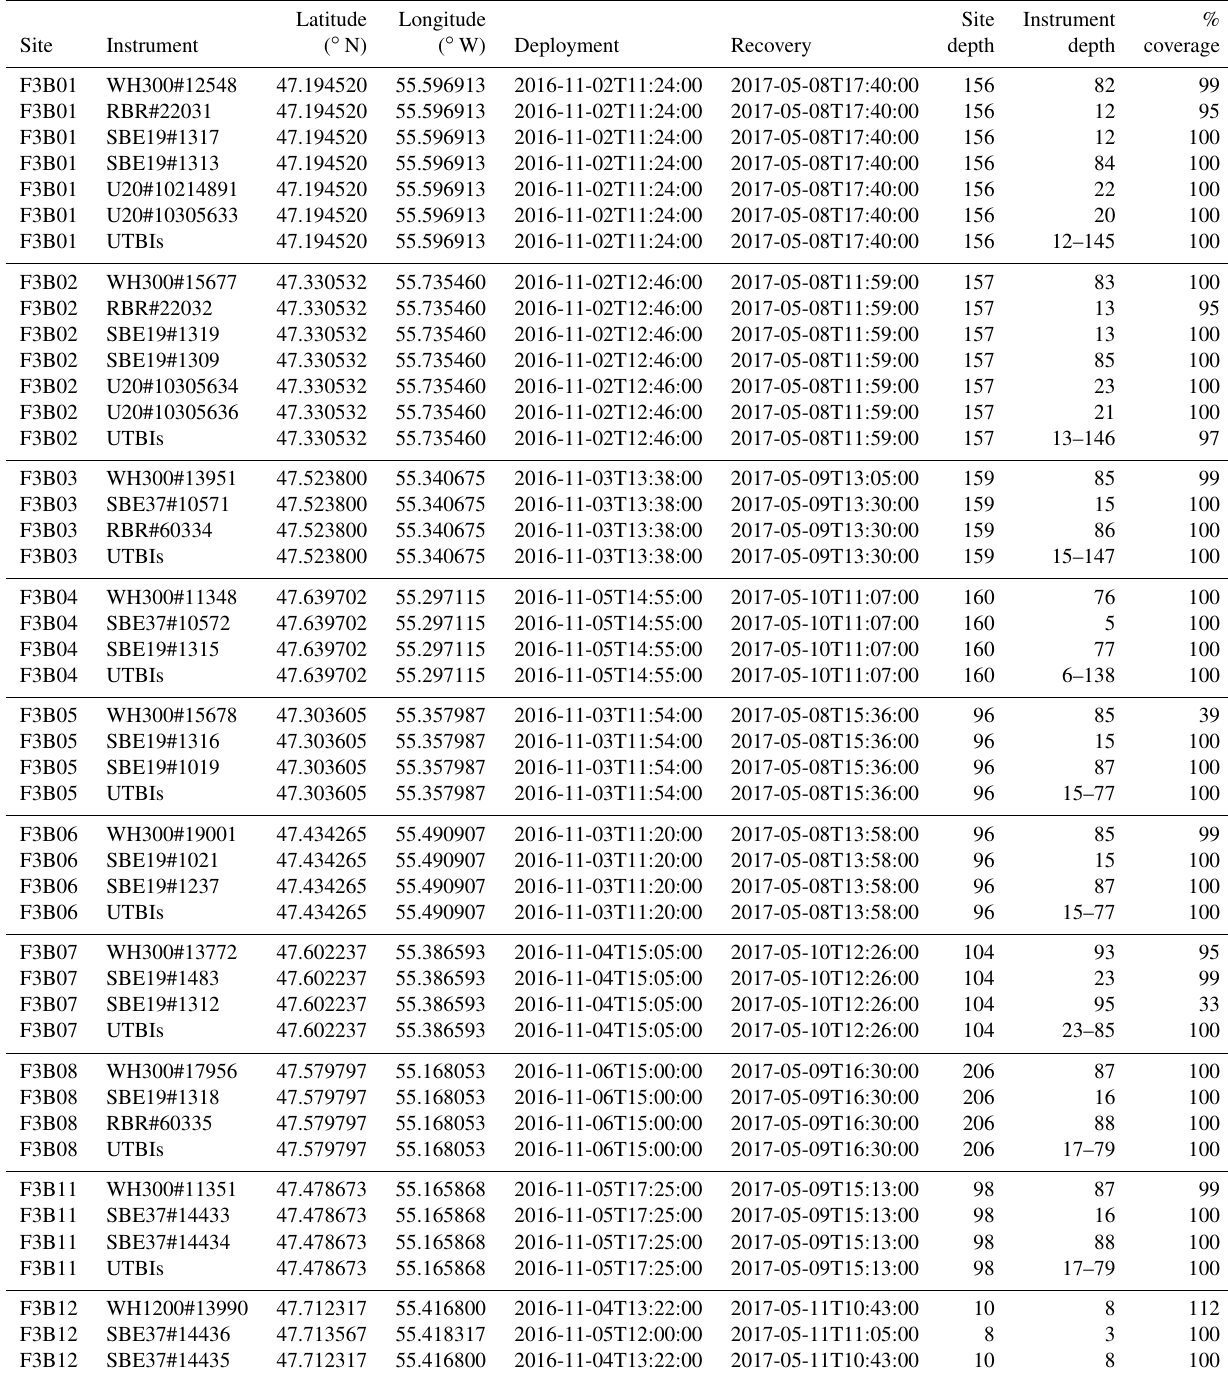
Table B4. Mooring data collection summary, leg 4 (November 2016–May